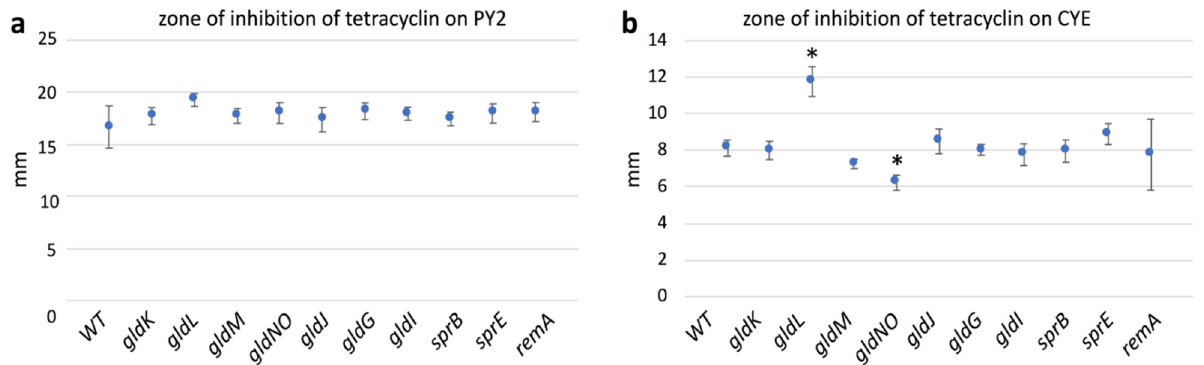
Figure 9. Antimicrobial effect in disc diffusion assay of WT and the mutants. Measurements of diameters of the inhibition zones of WT and the mutants against tetracycline. The plates of the disk diffusion test were incubated in ( a ) PY2 broth or ( b ) CYE medium for 2 days at 25 °C. The averages and standard deviations were indicated ( n = 4). Asterisks denote Student’s t -test significance compared with WT (* p < 0.05).